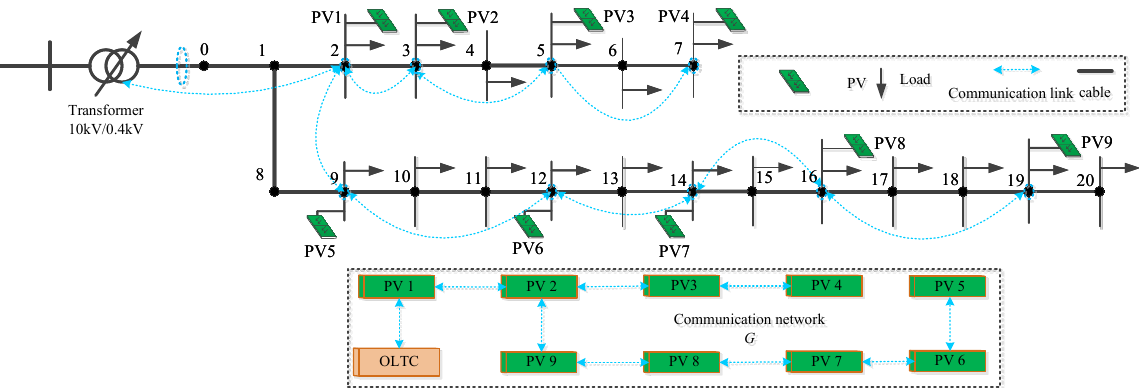
Figure 1. Node voltage regulation model of LVDN with a high proportion of distributed PV sources. The black arrow is the load of each node, while the dash blue lines with arrow are the communication links.